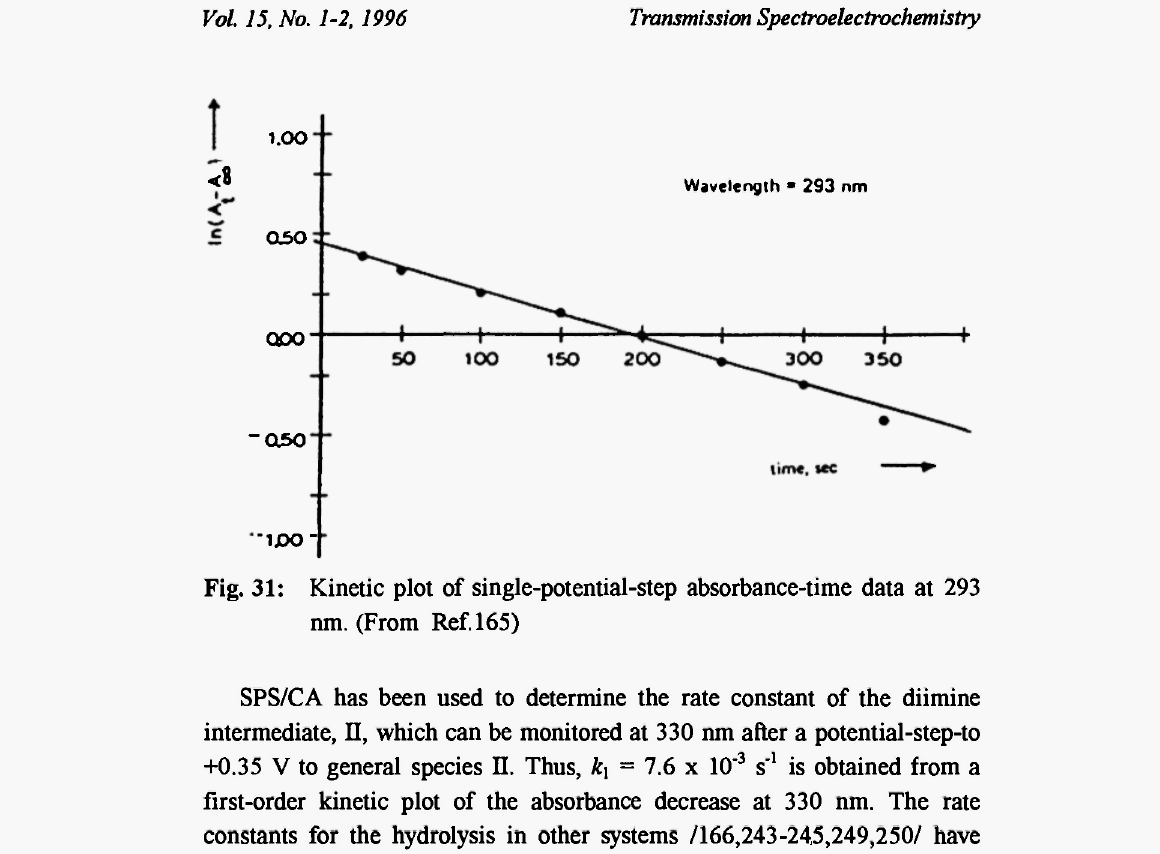
Fig. 31: Kinetic plot of single-potential-step absorbance-time data at 293 nm. (From Ref.